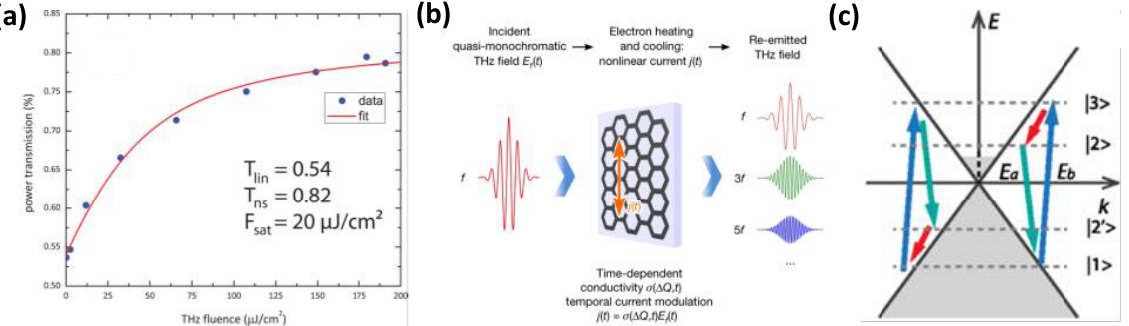
Figure 2. THz nonlinearities in graphene. ( a ) Nonlinear saturable absorption for THz; (Reprinted with permission from ref. [52]. Copyright 2013, American Chemical Society) ( b ) High harmonic emitted from the monolayer graphene excited by a multicycle THz wave [25]; ( c ) Schematic of DFG process. E a : photon energy of signal, E b : photon energy of pump. (Reprinted with permission from ref. [53]. Copyright 2014, American Physical Society)